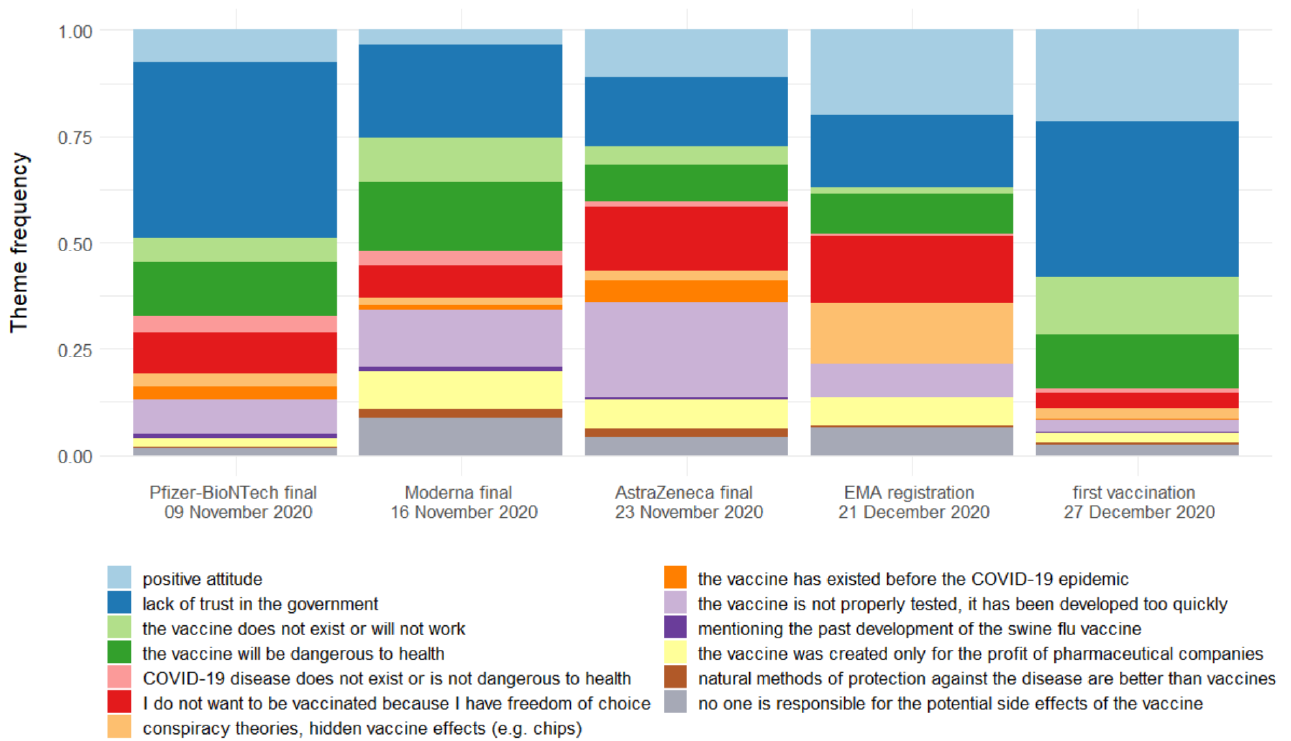
Figure 1. Distribution of